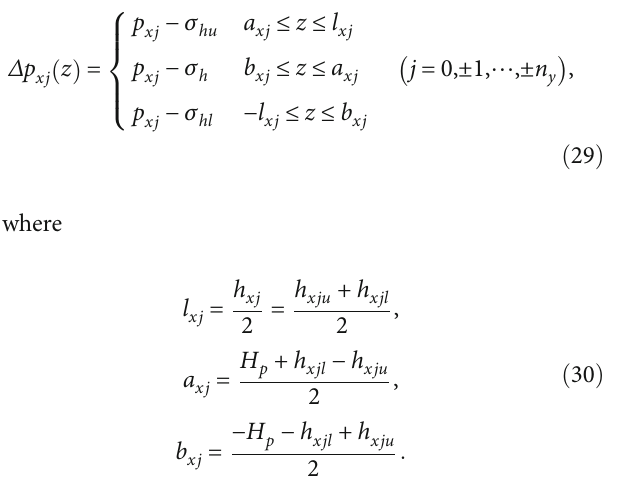
ffiffiffiffiffiffiffiffiffiffiffiffiffiffiffiffiffiffi l xj